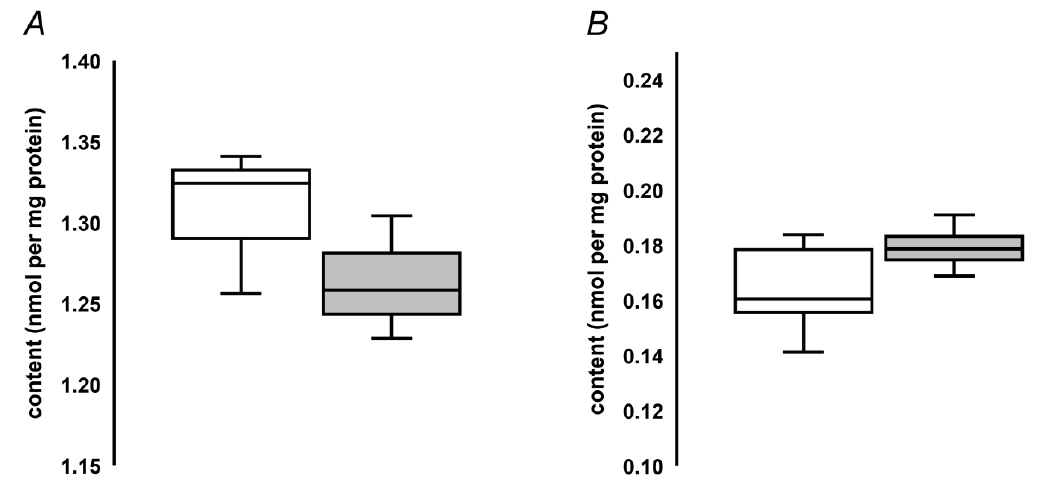
Figure 4. Quantification of MG-H1 adducts in pea seeds, subjected to accelerated ageing (5 days, 86% relative humidity, 45 °C, grey bars, n = 3) along with corresponding untreated controls (white bars, n = 3, A ), and oilseed rape seeds subjected to natural ageing at 18°C during nine years (grey bars, n = 5) along with corresponding controls stored during one year (white bars, n = 5, B ). The bars indicate median with the minimal and maximal values of the corresponding inter-quartile ranges.